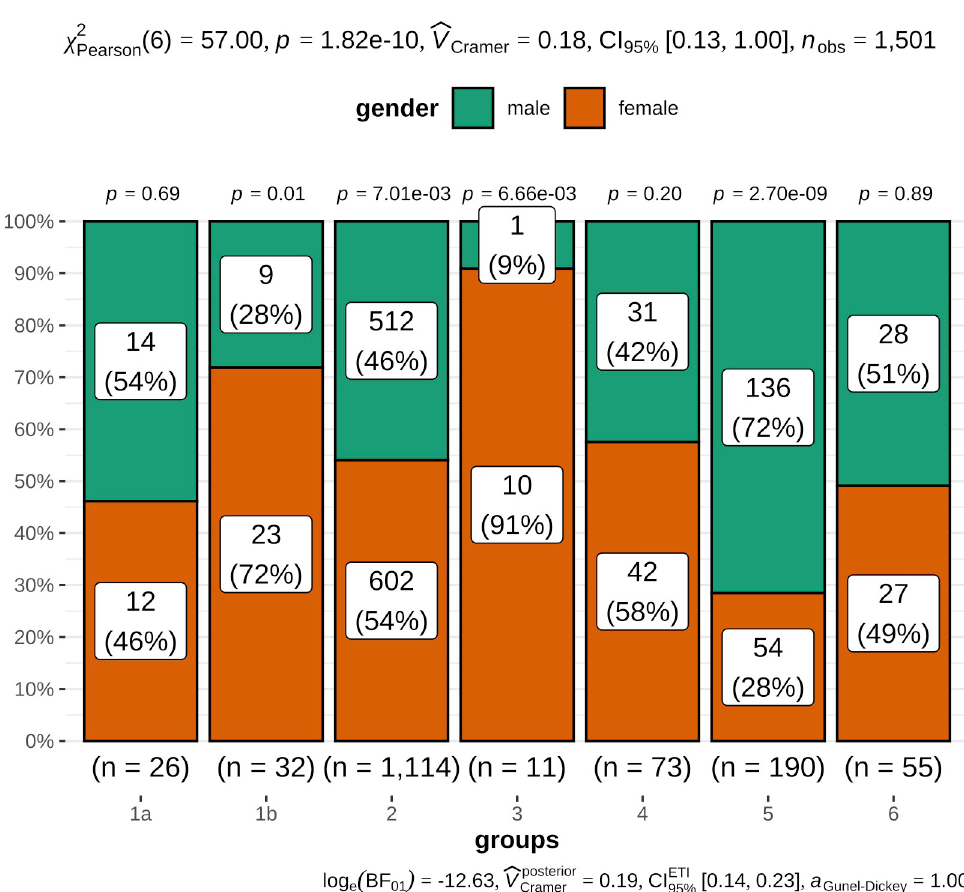
Fig 3. Stacked bar charts show the proportions of female and male dogs in the different groups. TgAA-positive hypothyroidism (group 1a), TgAA-negative hypothyroidism (group 1b), euthyroidism (group 2), subclinical hypothyroidism (group 3), TgAA-positive dogs with unremarkable thyroid function (group 4), potential nonthyroidal illness (group 5), unclassified dogs (group 6). The groups are displayed on the x-axis, and percentages are displayed on the y-axis. Absolute numbers and percentages are displayed in each category. The p value of < 0.001 indicates that gender and groups are dependent on each other; however, the V Cramer value of 0.18 with its 95% CI as the effect size next to the p value indicates only a weak association [46]. The Bayesian V Cramer effect size ( ^ V ^ posterior ) with its 95% highest density Cramer intervals of 0.20 also only shows a mild to moderate association [46]. In contrast, the Bayes factor (log e (BF 01 )) indicates decisive evidence for an association [46]. Proportion tests in each group show that the proportions of females and males differ significantly in groups 1b, 2, 3 (p � 0.01) and 5 (p < 0.001).